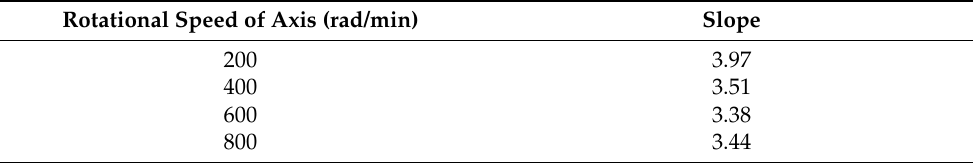
Table 5. Slope of the curve in Figure